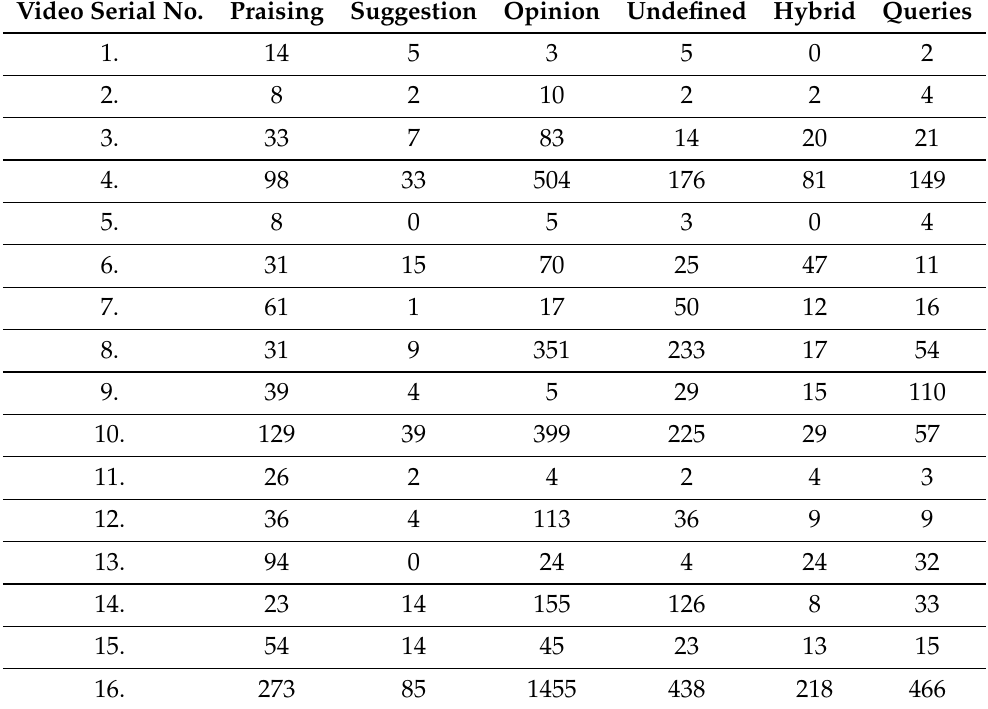
Table 9. Number of comments of each label type. Video Serial